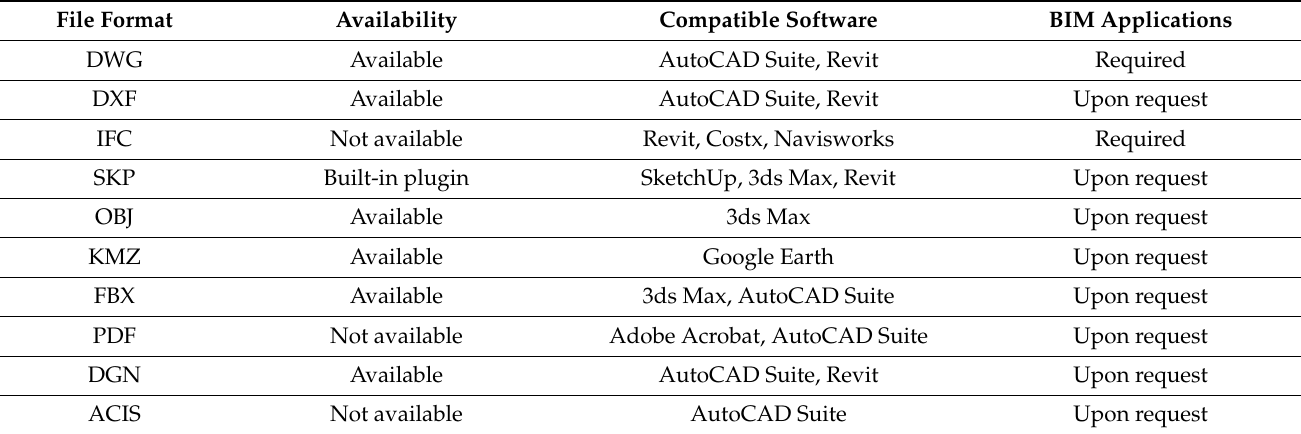
Table 7. Key File Formats in CAD with Exporting Availability of these Formats in Trimble